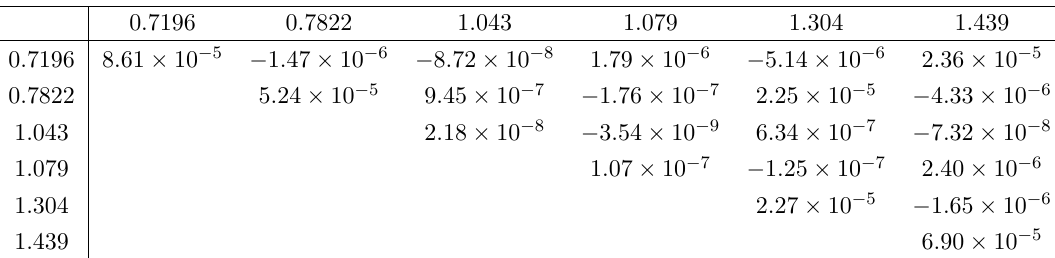
Table 8 . Covariance matrix for X cont , (cid:1) cont ( r i ; r j ). The (cid:12)rst row is r i =r 1 and the (cid:12)rst column latt is r j =r 1 . The ( i; j ) component is the numerical value of (cid:1) cont ( r i ; r j ). Note that (cid:1) cont ( r i ; r j ) is a symmetric matrix, and hence, we only show the elements of the upper triangular